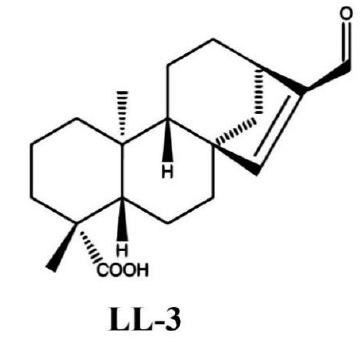
Figure 1. Chemical structure of ent -kaur-15-en-17-al-18-oic acid (LL-3). 2.2. E ff ect of LL-3 on A β 25-35 -Induced Cellular Reactive Oxygen Species Generation (cid:48) (cid:48) 2 ,7 -Dichlorodihydrofluorescein diacetate (DCFH-DA) probe that can be hydrolyzed by